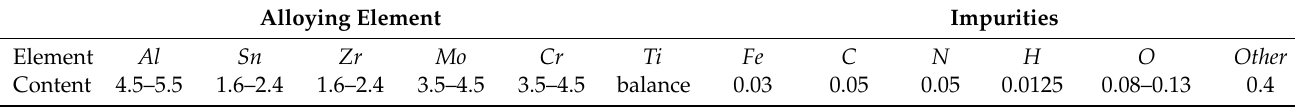
Table 1. Chemical composition of Ti-17 [mass fraction, %].